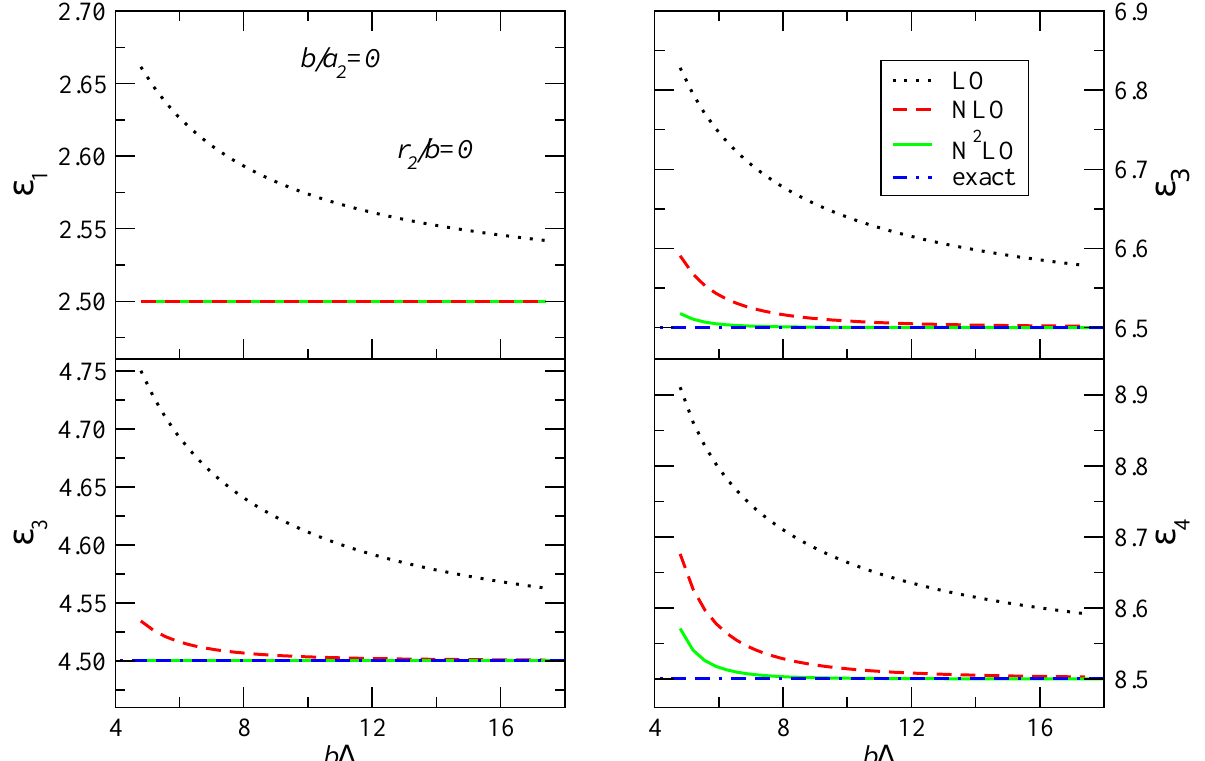
Fig. 2. Running of the energies of the first four excited states for two trapped particles at unitarity. The ground state is fixed in LO by means of Eq. (17). At NLO, the first excited state is used to fix C 2 , in addition to the ground-state energy, while at N 2 LO the second excited state is also used to fix C 4 . I assumed no physical e ff ective